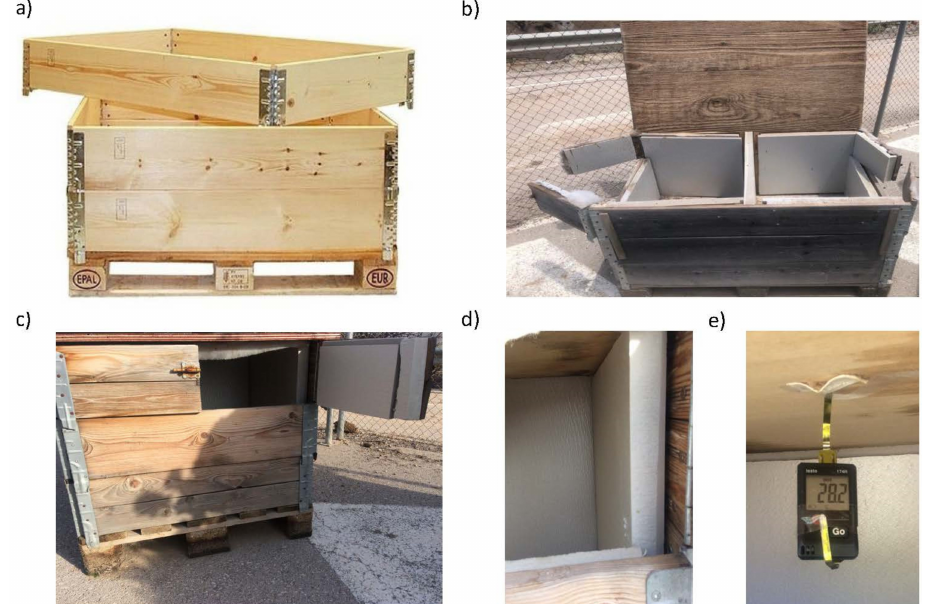
Figure 1. Euro-pallet support. ( a ) three wooden rectangular articulated bodies (image courtesy of www.rotomshop.es accessed on 4 January 2020); ( b ) interior space divided into two compartments; ( c ) access door; ( d ) expanded polystyrene insulation; ( e ) thermo-hygrometric TESTO 174H sensors/data- loggers hanging on the wood